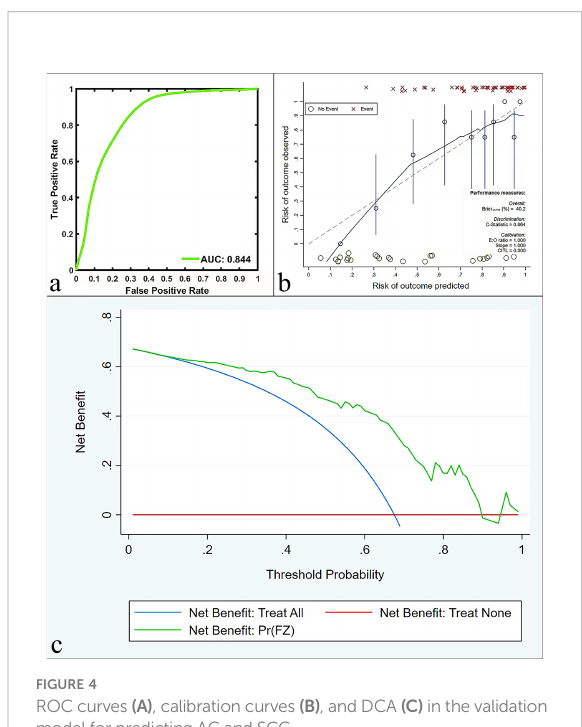
FIGURE 4 ROC curves (A) , calibration curves (B) , and DCA (C) in the validation model for predicting ACand SCC.